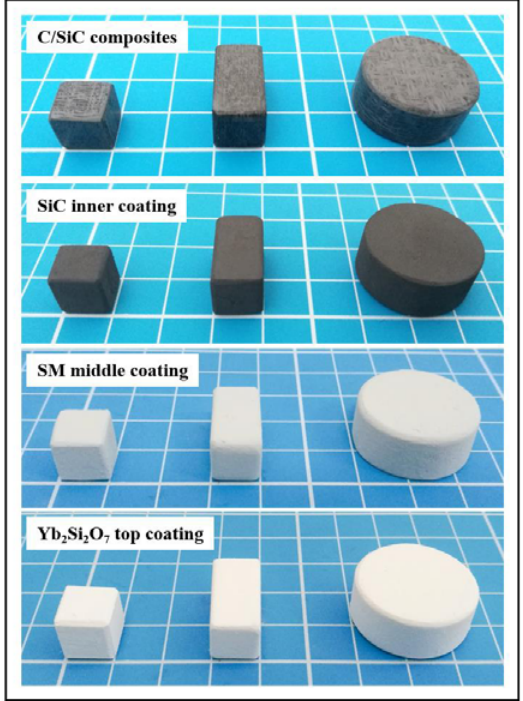
Fig. 3 Macromorphology of each layer in the tri-layer Yb 2 Si 2 O 7 /SM/SiC coating prepared on the surface of C f /SiC composites with different